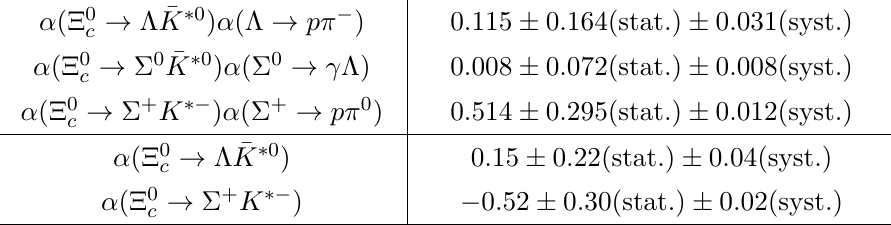
Figure 4 . The cos θ Λ , cos θ , and cos θ distributions after efficiency corrections from data Σ 0 Σ + samples. The lines show the fitted result with functions of eq. (5.1), eq. (5.2), and eq. (5.3).